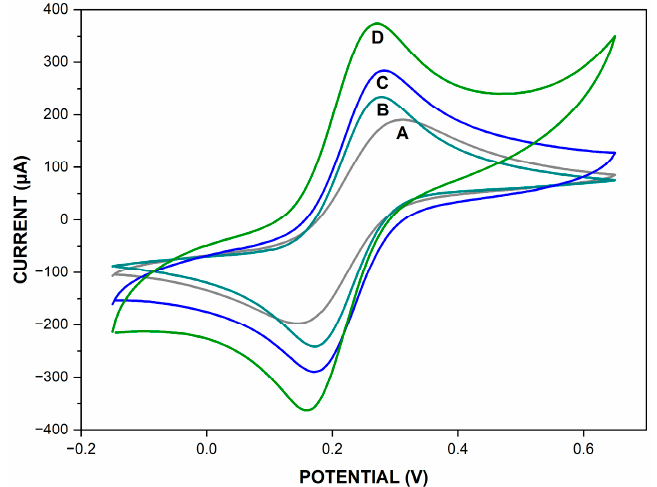
Figure 1. Cyclic voltammograms of bare PGE (A), CB/PGE (B), AuNPs/CB/PGE (C), and CysAm/AuNPs/CB/PGE (D) recorded in 5 mM [Fe(CN) 6 ] 3 − /4 − containing 0.1 M KCl.